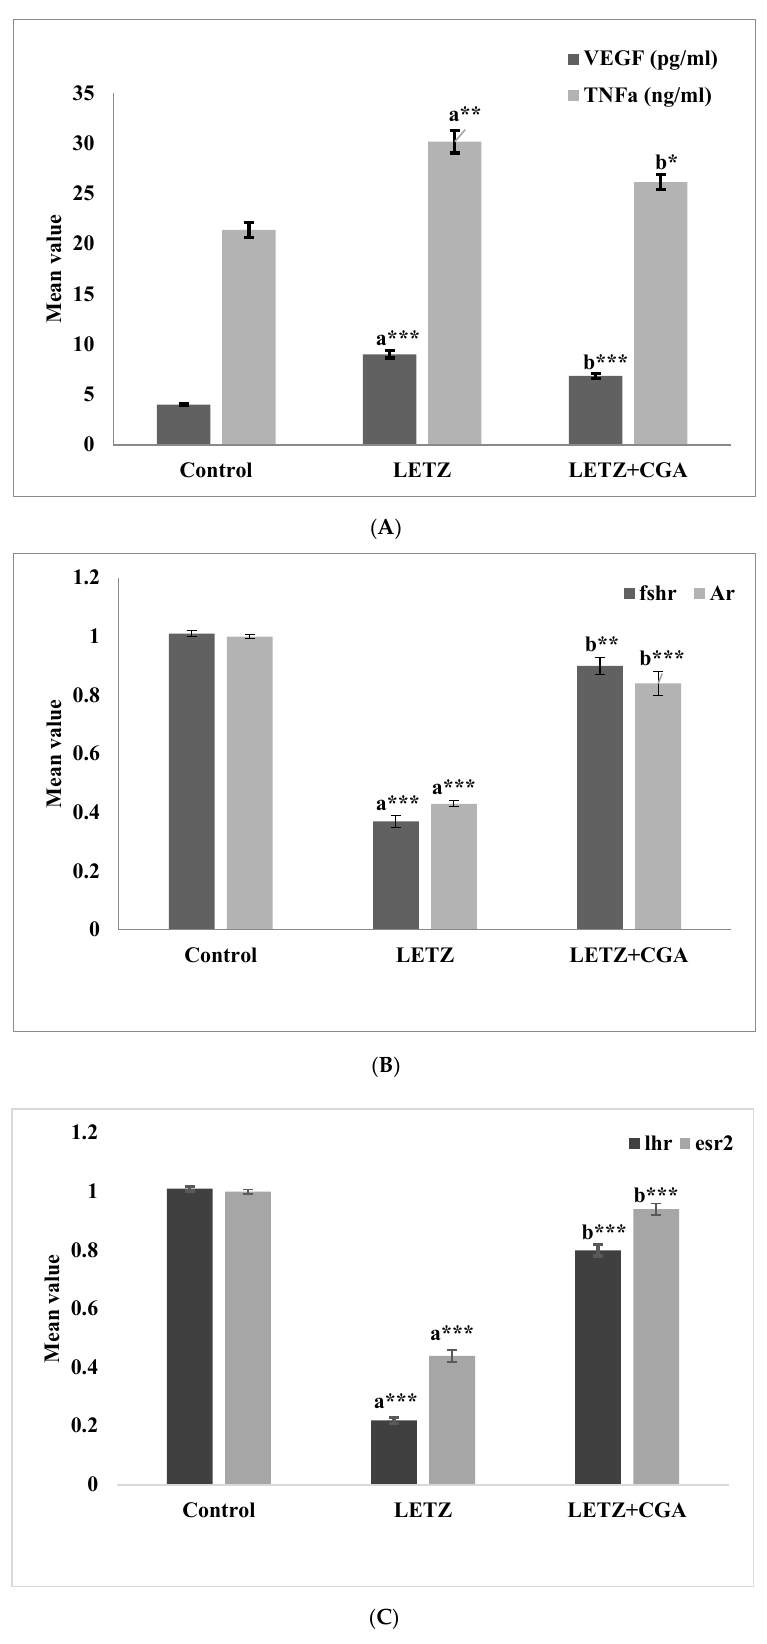
Figure 4. ( A ) Effect of CGA on VEGF and TNF α levels in mice with PCOS. Control: normal saline; PCOS: letrozole (6 mg/kg); PCOS with CGA: LETZ at 6 mg/kg and CGA at 50 mg/kg; a = LETZ versus control; b = LETZ versus LETZ with CGA. With n = 6 per group, all values are expressed as means with standard errors. *** p < 0.001, ** p < 0.01, and * p < 0.05; CGA = chlorogenic acid; LETZ = letrozole. ( B ) Effect of CGA on fshr and Ar expressions in mice with PCOS. Control: normal saline; PCOS: letrozole (6 mg/kg); PCOS with CGA: LETZ at 6 mg/kg and CGA at 50 mg/kg; a = LETZ versus control; b = LETZ versus LETZ with CGA. With n = 6 per group, all values are expressed as means with standard errors. *** p < 0.001; ** p < 0.01; CGA = chlorogenic acid; LETZ = letrozole. ( C ) Effect of CGA on lhr and esr2 expressions in mice with PCOS. Control: normal saline; PCOS: letro ‐ zole (6 mg/kg); PCOS with CGA: LETZ at 6 mg/kg and CGA at 50 mg/kg); a = LETZ versus control; b = LETZ versus LETZ with CGA. With n = 6 per group, all values are expressed as means with standard errors. *** p < 0.001; CGA = chlorogenic acid; LETZ = letrozole. 3.6. CGA Treatment Increases the Levels of Adiponectin and Adipo ‐ R1 Expression in PCOS Mice In our study, we observed the plasma levels of adiponectin and adipo r1 expression in the ovarian tissue, both of which were decreased significantly ( p < 0.001) in LETZ ‐ treated mice. Treatment of mice with PCOS using CGA caused a significant increase ( p < 0.001) in their levels, and the results are shown in Figure 5A,B.